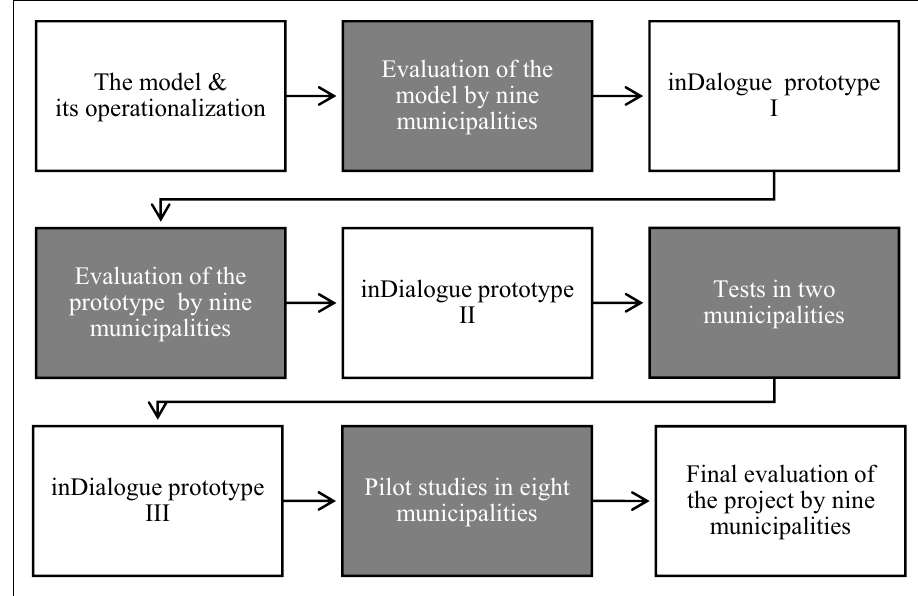
Figure 2: The model for research and action in the inDialogue project